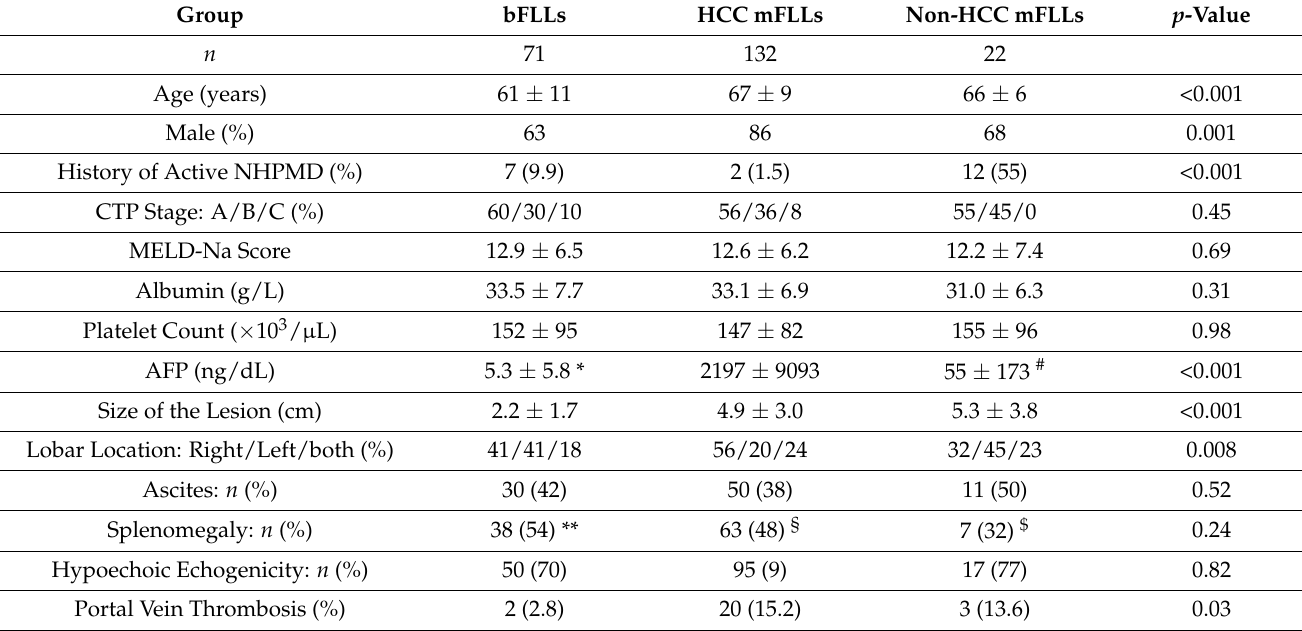
Table 3. The distribution of the different FLL groups according to the clinical, laboratory, and sonographic characteristics of the 225 study